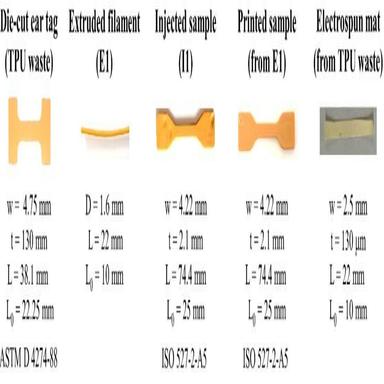
Different samples used for the mechanical behaviour analysis and their dimensions.